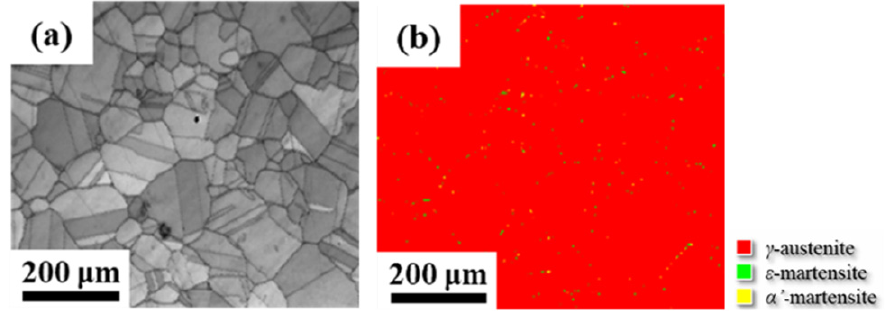
Figure 2. Electron back-scattered diffraction (EBSD) analysis of AISI304 blocks before wear test: ( a ) image quality (IQ) maps and ( b ) corresponding phase maps (PM).